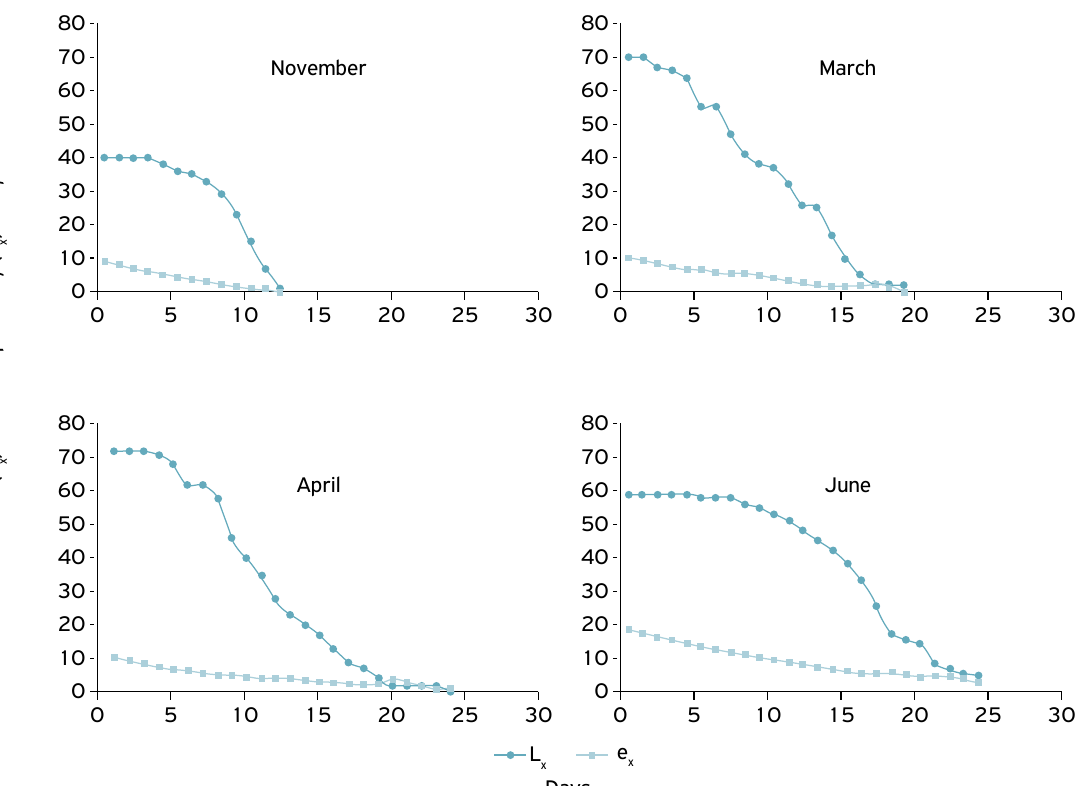
) and life expectancy (e ) of Aphis craccivora in cowpea under “natural” conditions. Teresina, Piauí, Figure 1. Survival (L x x